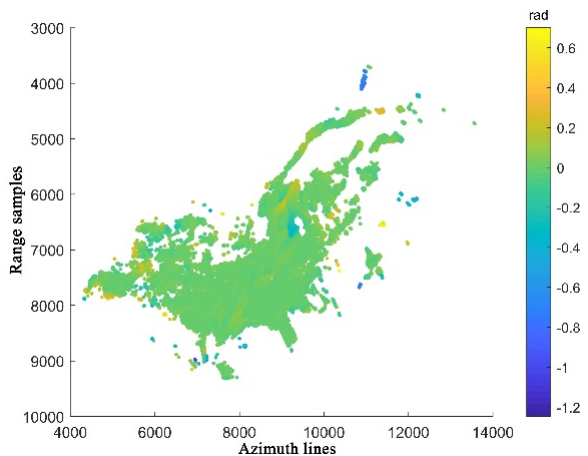
Figure 20. Residual deformation phase diagram. The residual deformation phase can be calculated Fig 19 . Interpolated atmospheric phase diagram. In the study by subtracting the interpolated atmospheric phase from the Fig 20 . Residual deformation phase diagram. The residual area, the stable region is selected by taking the shape variable deformation phase can be calculated by subtracting the as the threshold, and the phase of the stable region is interpolated atmospheric phase from the residual. interpolated to obtain the overall atmospheric delay phase.